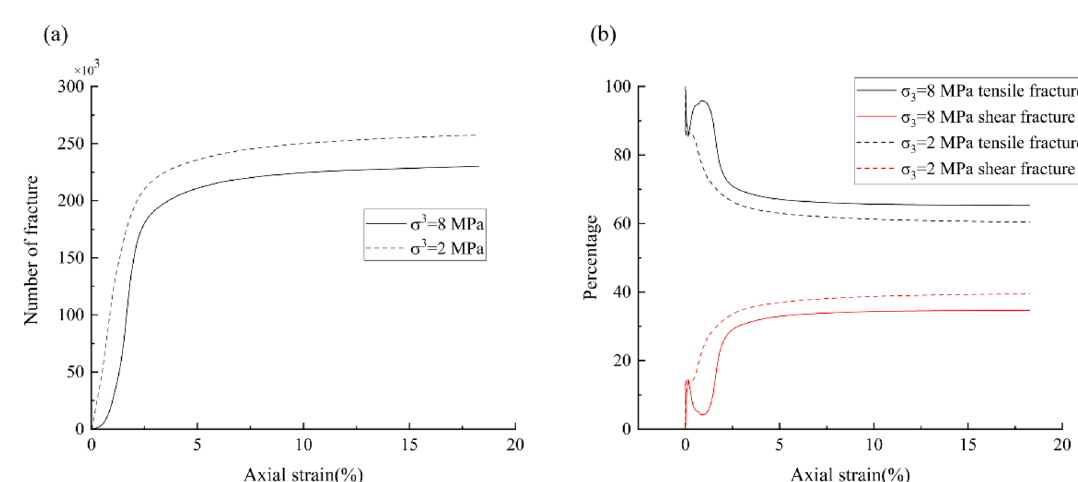
Figure 9. The number of tensile and shear fracture at different confining pressure: ( a ) all fracture; ( b ) percentage of different